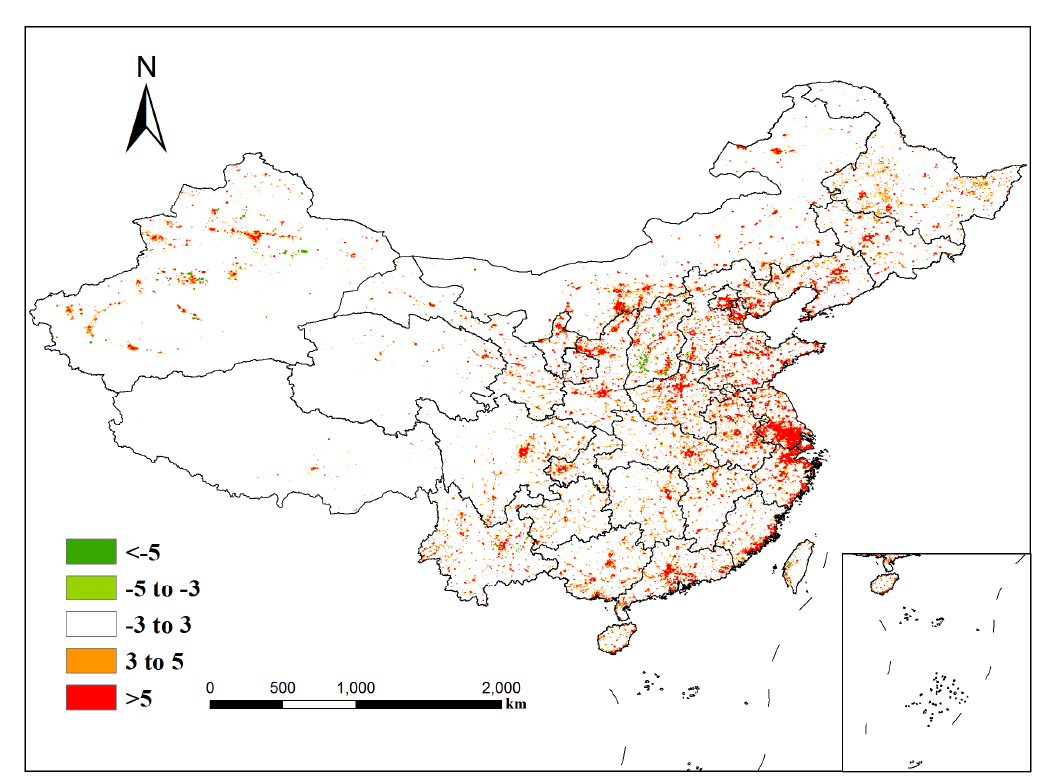
Figure 7. Change in brightness (calibrated digital number) between 2000–2004 and